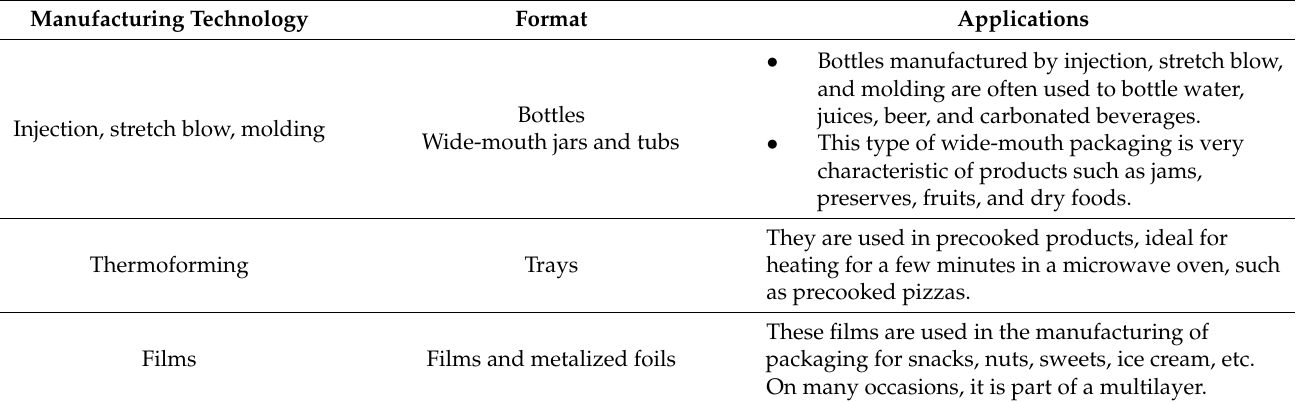
Table 4. Application for PET-based products and manufacturing technology. Adapted from Table 1 in reference